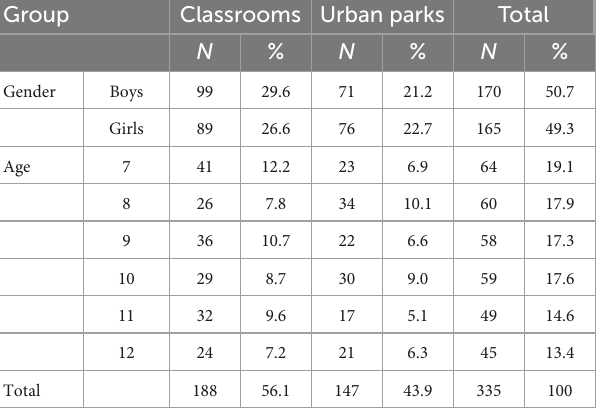
as contributing to restorative potential as children’s awareness and preference for environment sound strongly differ from those of adults (McAllister et al.,